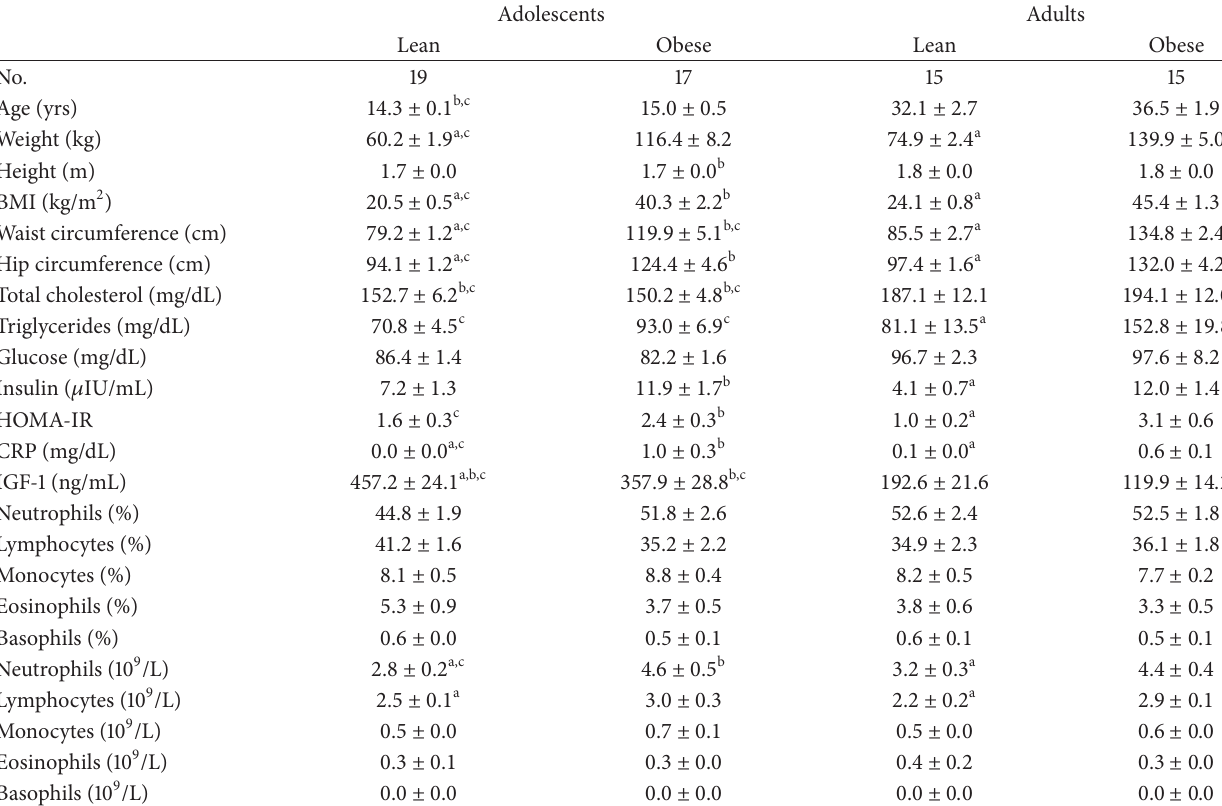
Table 1: Demographic, clinical, metabolic, haematological, and hormonal characteristics of the study